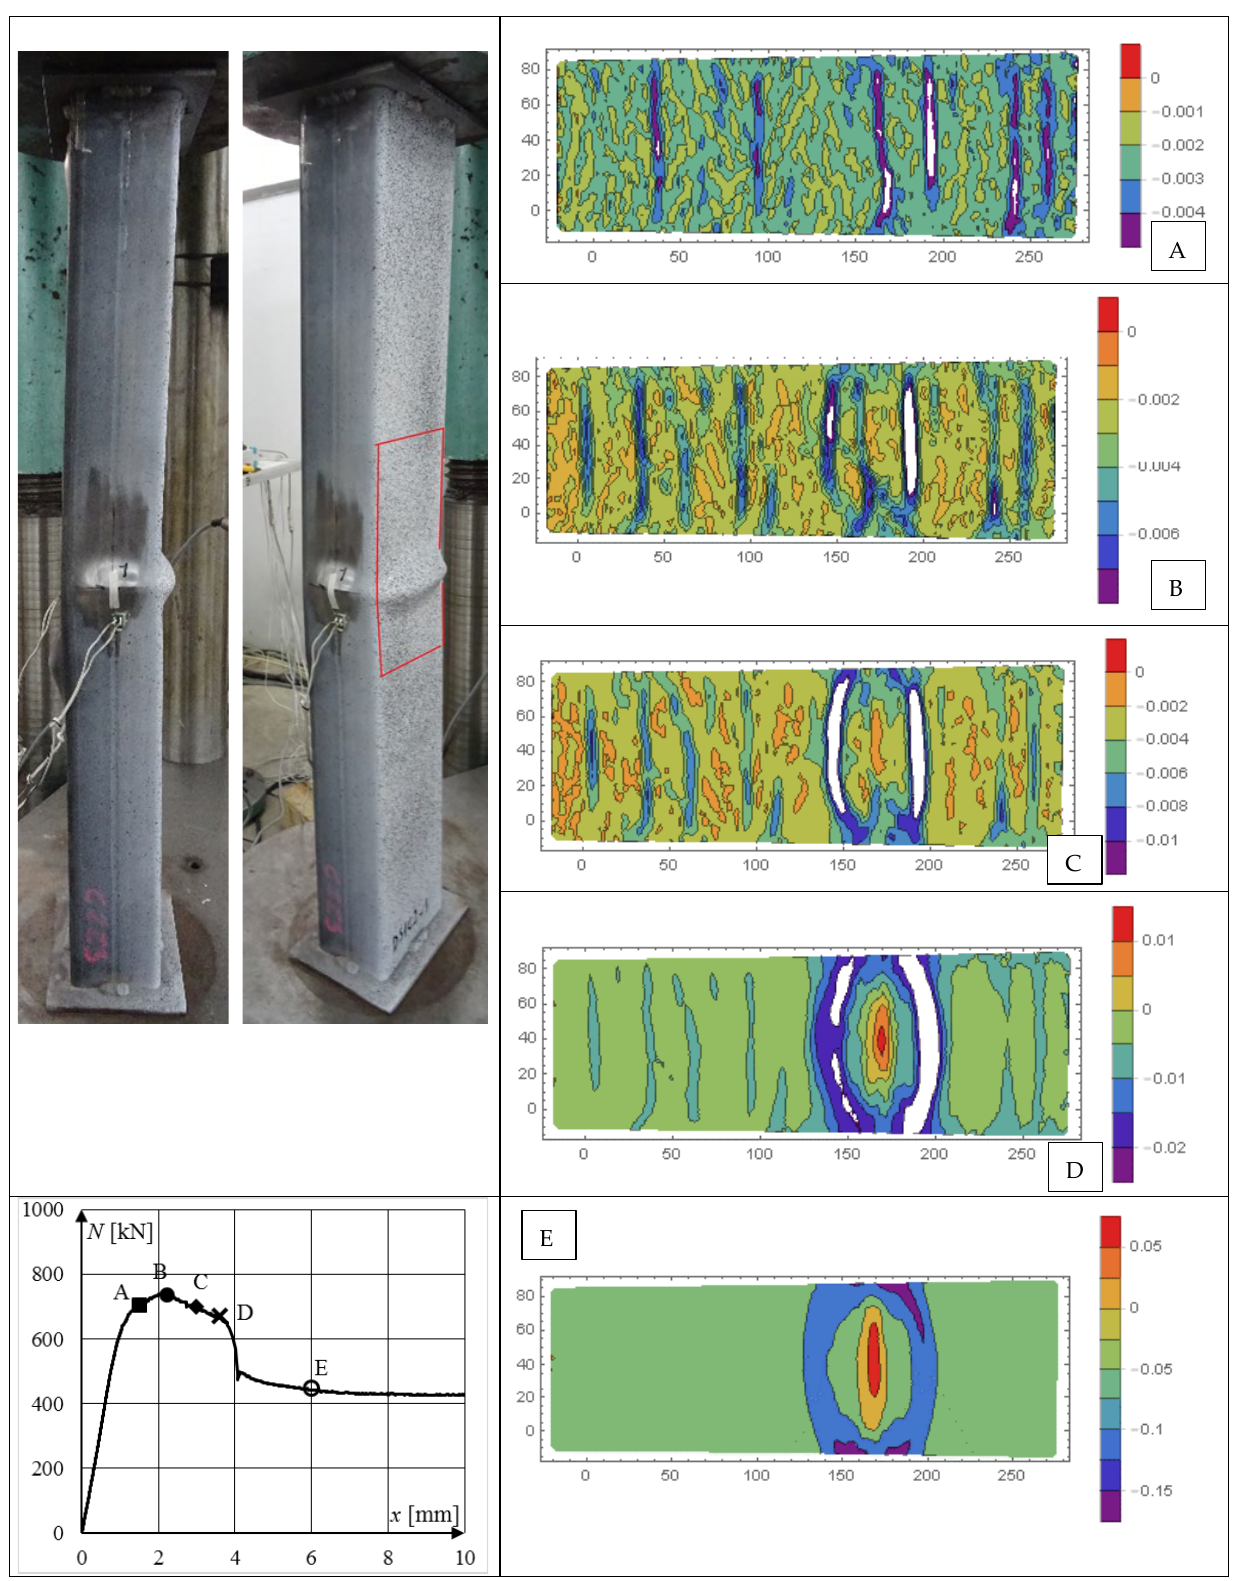
Figure 18. Evolution of strains ε xx in column DS1C2_1, steel S235, stronger concrete, ξ = 0.90.Points ( A , B ) indicate strains before reaching the ultimate load and when the maximum force was reached, respectively. Points ( C – E ) mark selected places in the post-peak part of the equilibrium